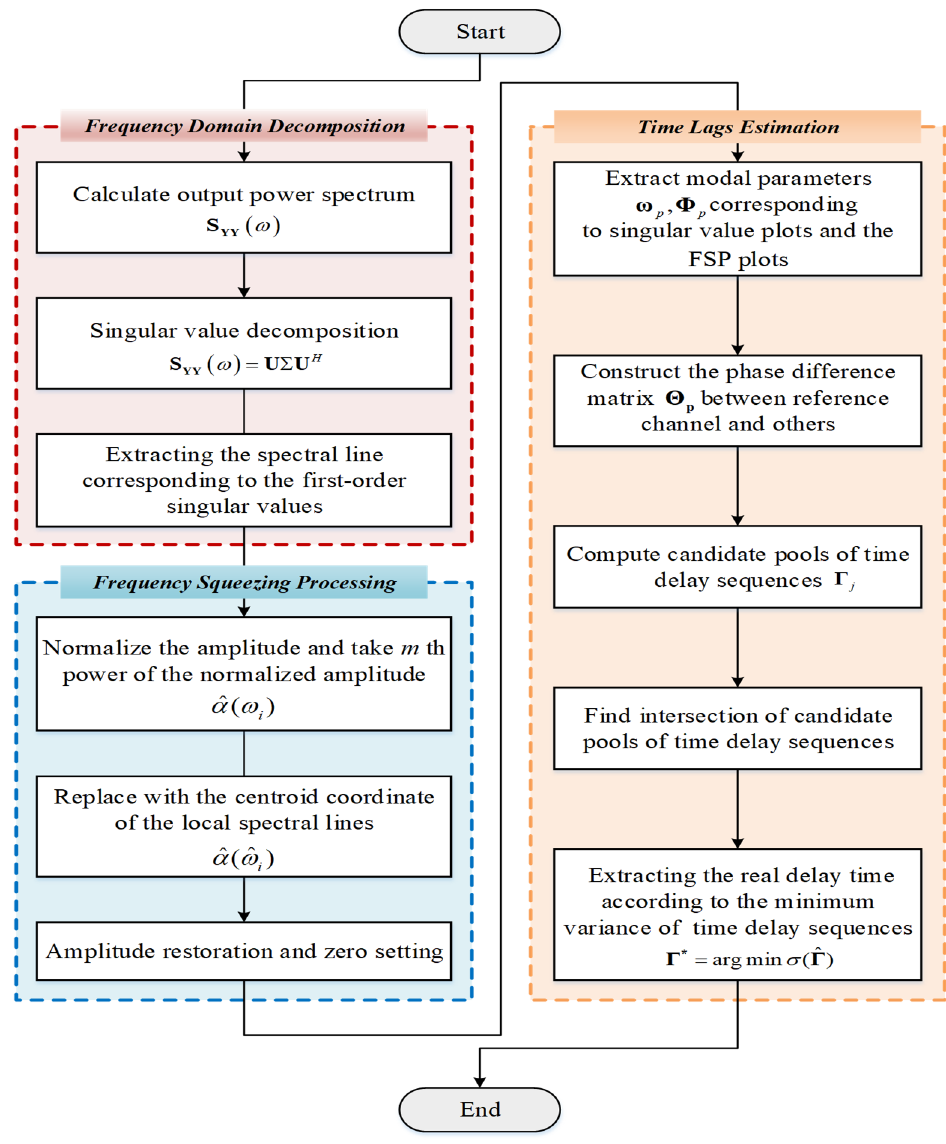
Figure 1. Flowchart of non-synchronous measurement correction with FSP-FDD.